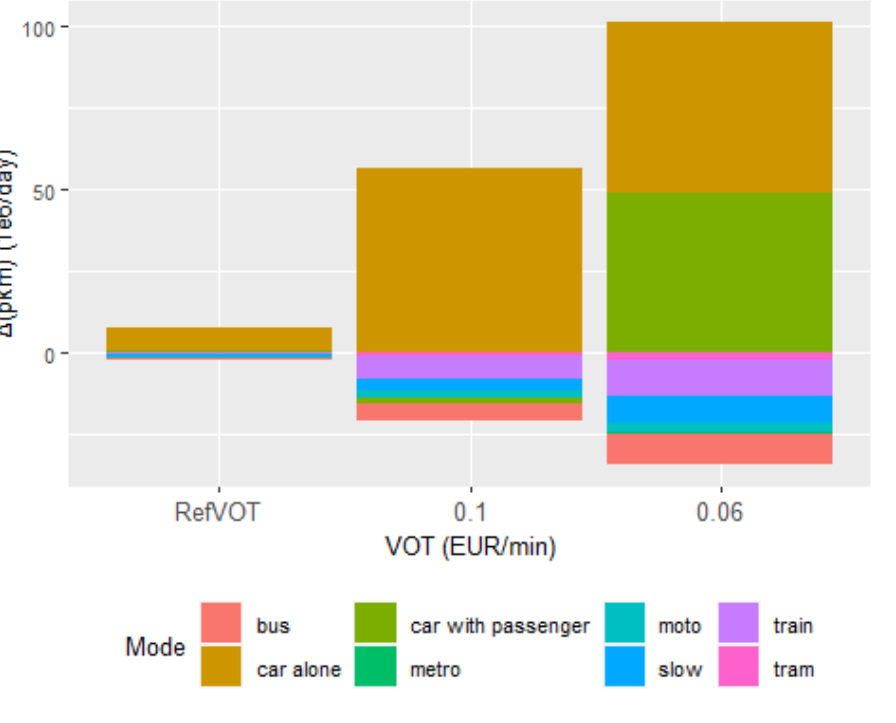
Figure 4. Absolute changes in pkm per mode compared to the reference